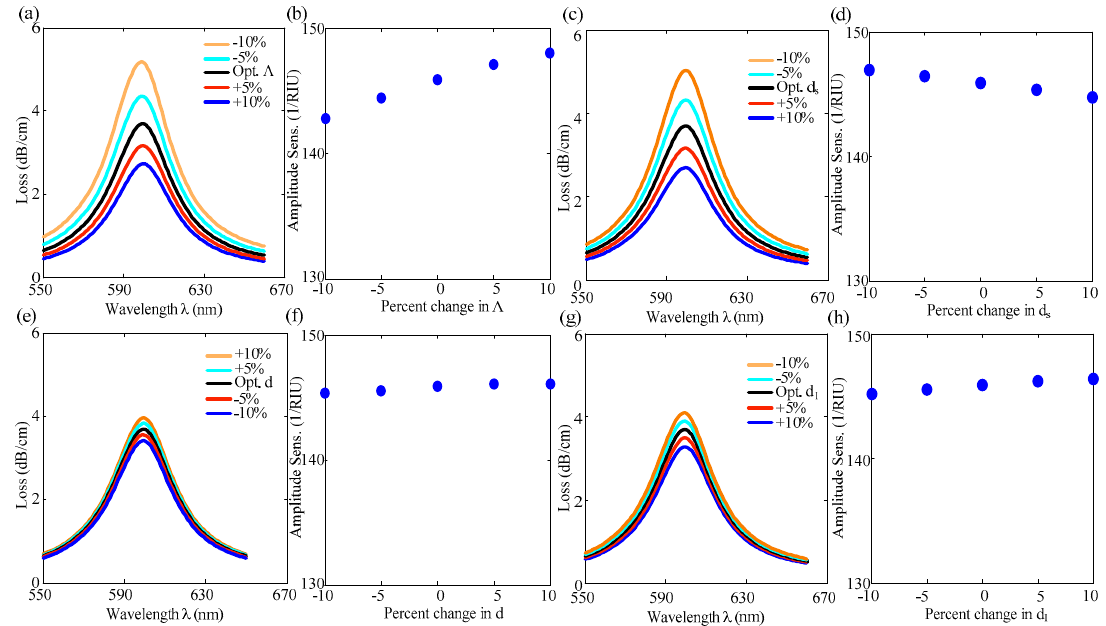
Figure 9. Investigation of the sensor’s structural parameters for analyte RI = 1.34. Effect of pitch Λ : ( a ) loss spectra ( b ) amplitude sensitivity, and effect of air-hole diameter d s : ( c )loss spectra, ( d ) amplitude sensitivity, and effect of air-hole diameter d: ( e ) loss spectra, ( f ) amplitude sensitivity, and effect of air-hole diameter d 1 : ( g ) loss spectra and ( h ) amplitude sensitivity. Table 2. Performance evaluation of existing open channel sensors in terms of sensing parameters with the proposed sensor.